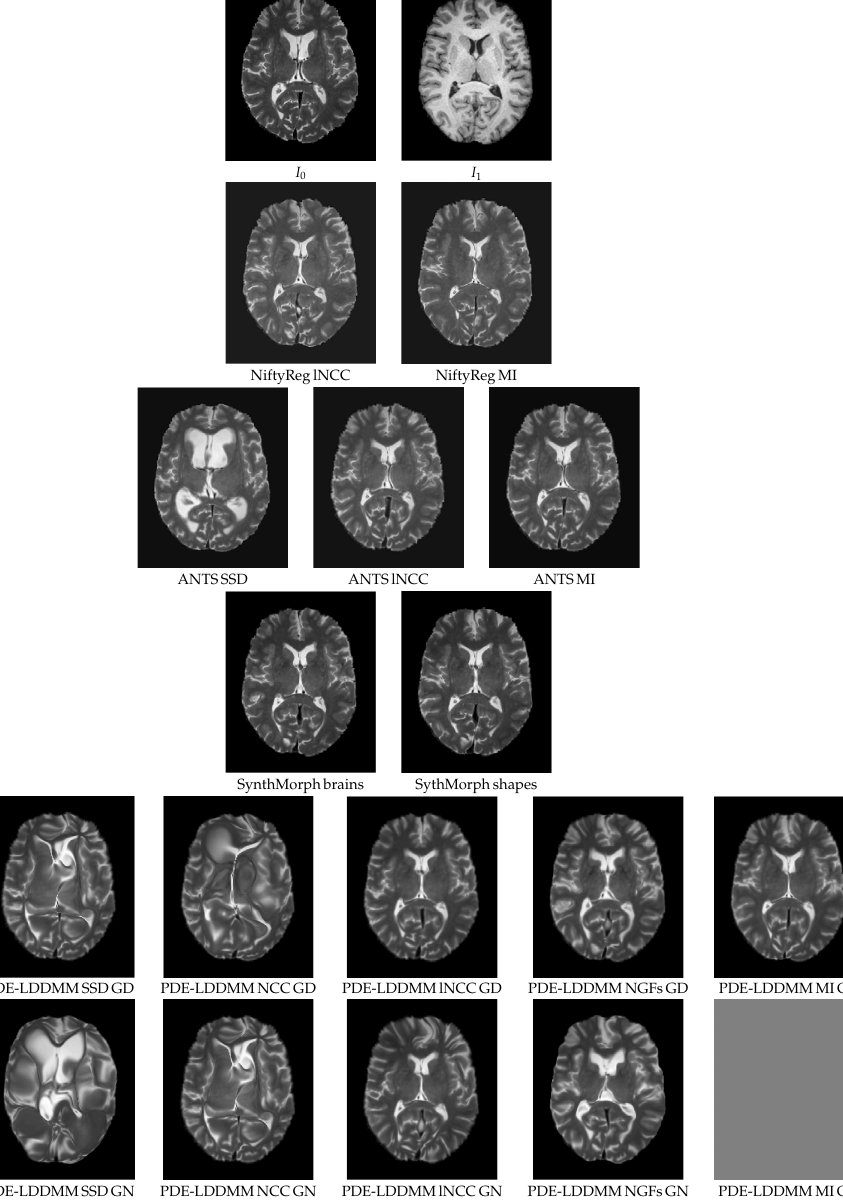
Figure 8. Oasis. BL PDE-LDDMM Variant II. Warped sources obtained for the methods considered in the multimodal simulated experiment.